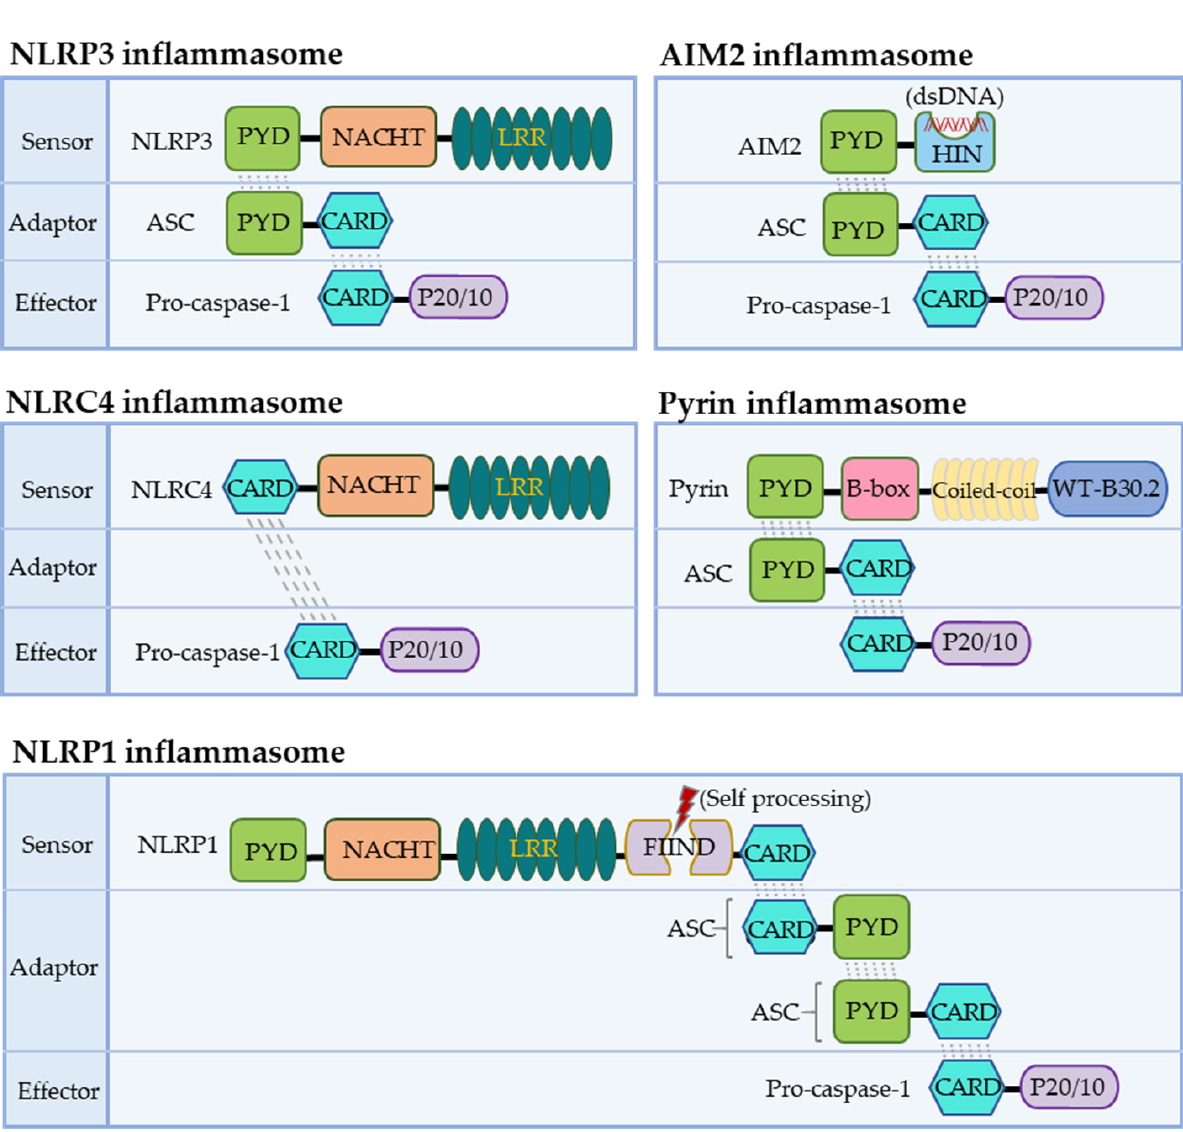
Figure 1. Domain architecture of canonical inflammasome sensors. Overview and alignment of the distinct domains for sensors that initiate canonical inflammasome signaling.